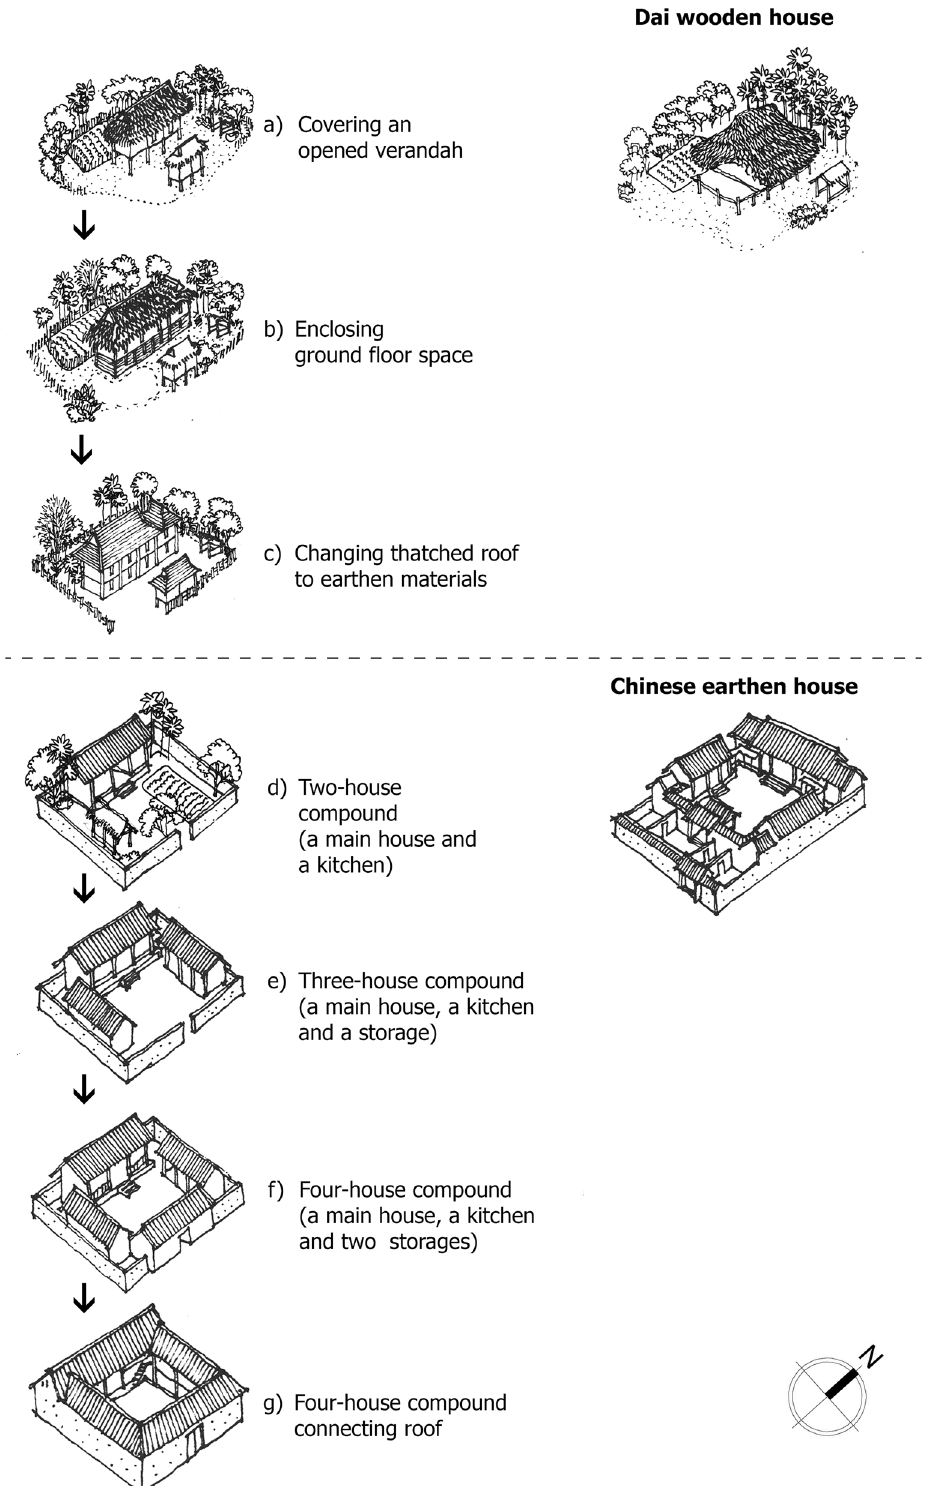
Fig. 3 Development of different house forms in Dehong Prefecture (Source: the